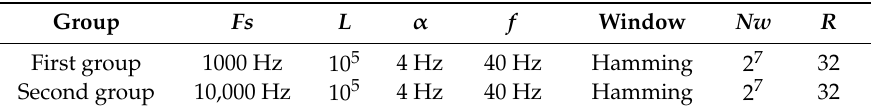
Table 2. Parameters settings used in simulated signal.